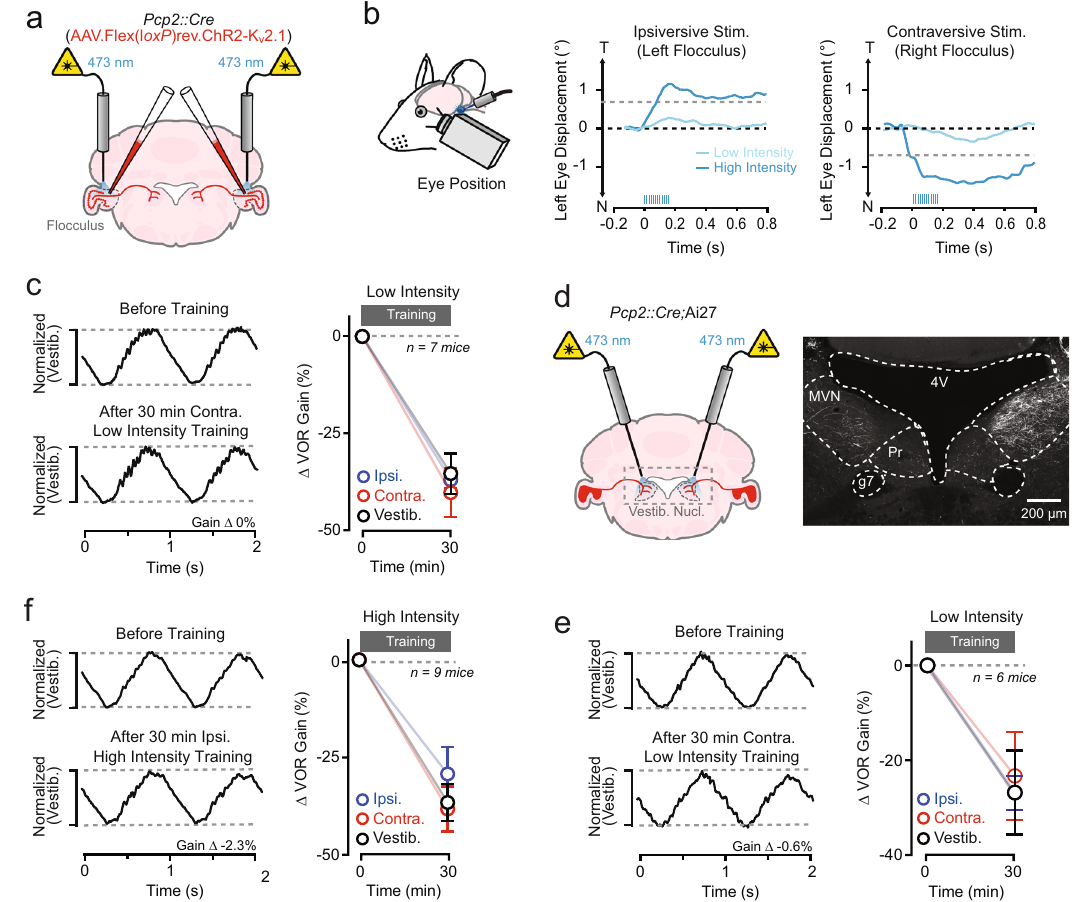
Fig. 6 Absence of motor learning with optogenetically induced PC simple spike fi ring. a Pcp2::Cre mice were implanted with bilateral optical fi bers to stimulate fl occular PCs expressing soma-targeted ChR2-K v 2.1 by AAV-mediated transduction. b To calibrate the intensity of the optogenetic stimulus, evoked eye movements were monitored in response to activation of ChR2-K v 2.1-expressing PCs (12 pulses, 5 – 10ms; 50Hz). c Average VOR-evoked eye movements measured before and after training with low-intensity optogenetic stimuli timed to the end of contraversive vestibular motion. The traces were normalized to that of time-matched, control responses recorded during training sessions consisting of vestibular motion alone. The summary plot shows the lack of effect of pairing low-intensity optogenetic PC activation with vestibular motion on VOR gain. d Pcp2::Cre; Ai27 mice were implanted with bilateral optical fi bers targeting the medial vestibular nuclei (MVN) to activate the ChR2-expressing axon projections of fl occular PCs. The image on the right shows ChR2-tdTom expressing PC terminals in the MVN (fourth ventricle, 4 V; genu of CN VII, g7). e VOR-evoked eye movements before and after pairing low- intensity optogenetic activation of PC axons with vestibular motion on normalized VOR performance. Summary plot show a lack of an effect of both contraversive and ipsiversive pairing contexts compared to control training sessions. Data are presented as mean ±SEM and analyzed with two-way repeated-measures ANOVA with Dunnett ’ s post test. f Comparison of VOR performance before and after pairing with high-intensity optogentic stimulation of ChR2-K v 2.1-expressing PCs in the fl occulus, timed to the end of ipsiversive vestibular motion. Summary data from all mice is shown on the